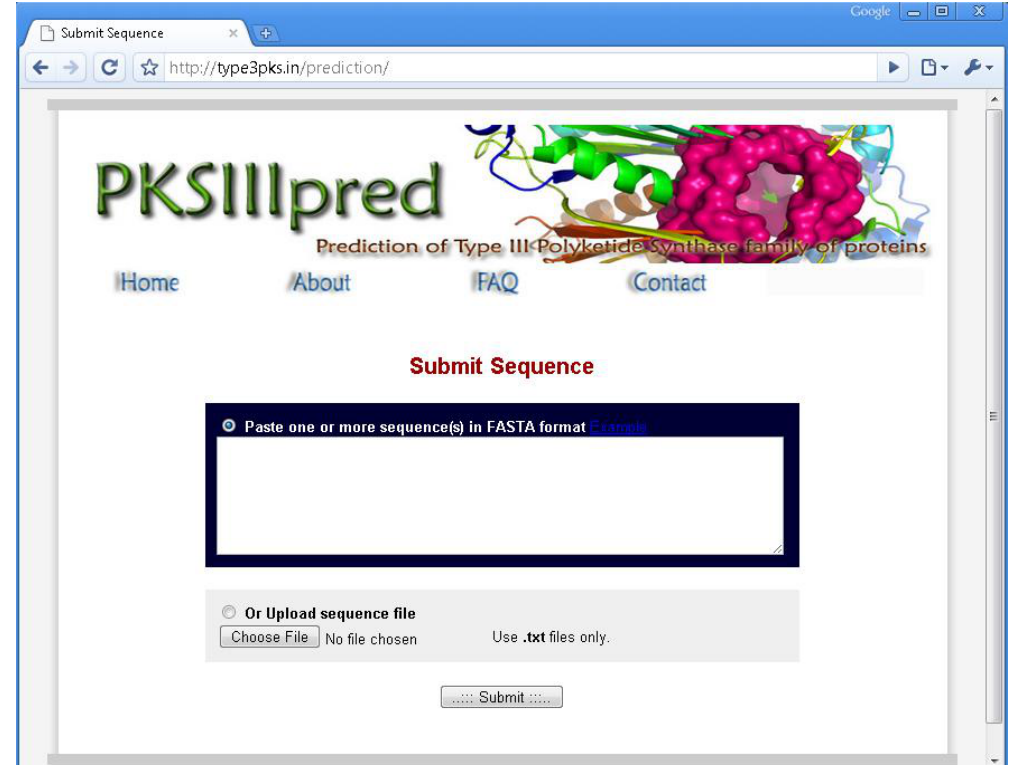
Figure 1: Web interface of